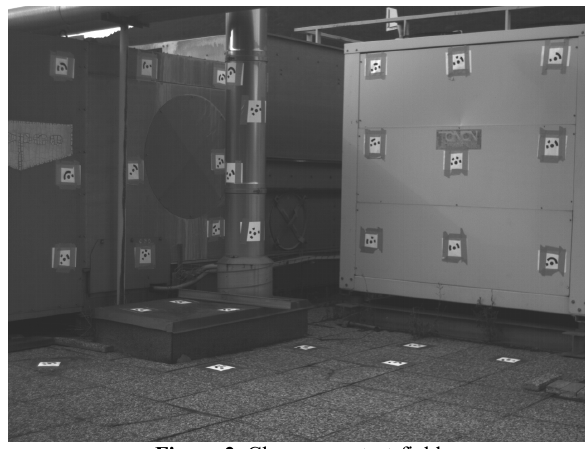
Figure 2 . Close-range test-field